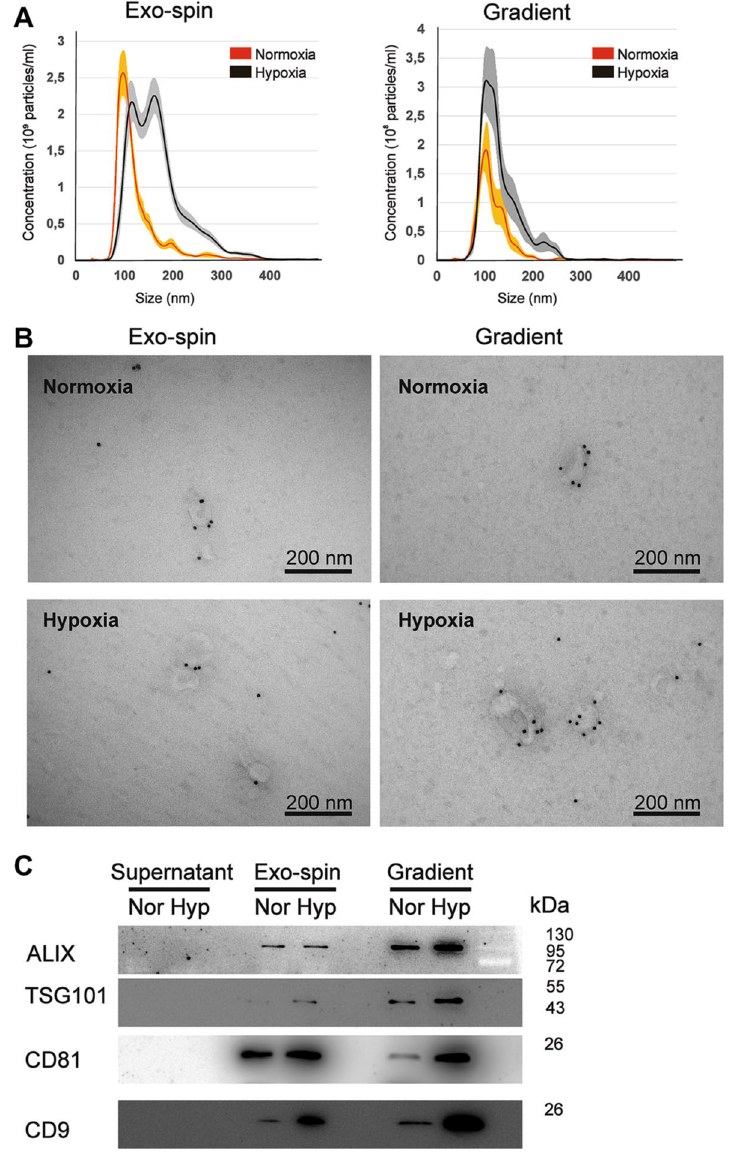
Figure 2. Characterization of EVs produced by Renca cells cultured under normoxia (Nor) or hypoxia (Hyp) and isolated by using either density gradient ultracentrifugation (Gradient) or sequential ultracentrifugation followed by Exo-spin size exchange chromatography (Exo-spin). ( A ) EV concentrations and size distribution measured by NTA. ( B ) Immuno-TEM with anti-CD63 antibody (magnification 1:49,000, images of the same regions with lower magnification are shown in Supplementary Figure S2A). ( C ) Western blot with antibodies against common EV markers (images of uncropped blots are shown in Supplementary Figure